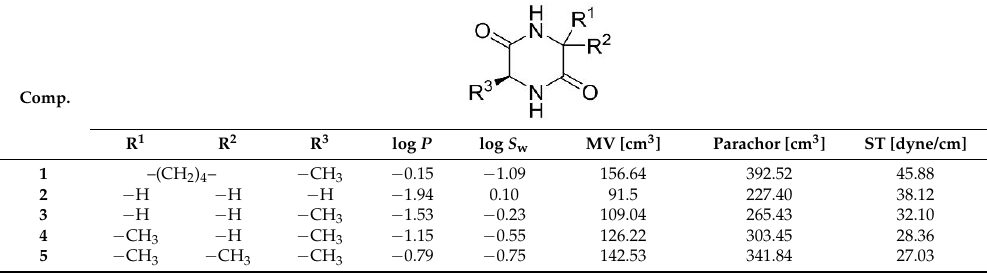
Table 1. Structure and calculated (ACD/Percepta ver. 2012) physicochemical properties of alaptide ( 1 ) and its derivatives 2 – 5 : lipophilicity (log P ), water solubility (log S w ), molar volume (MV [cm 3 ]), parachor [cm 3 ], and surface tension (ST